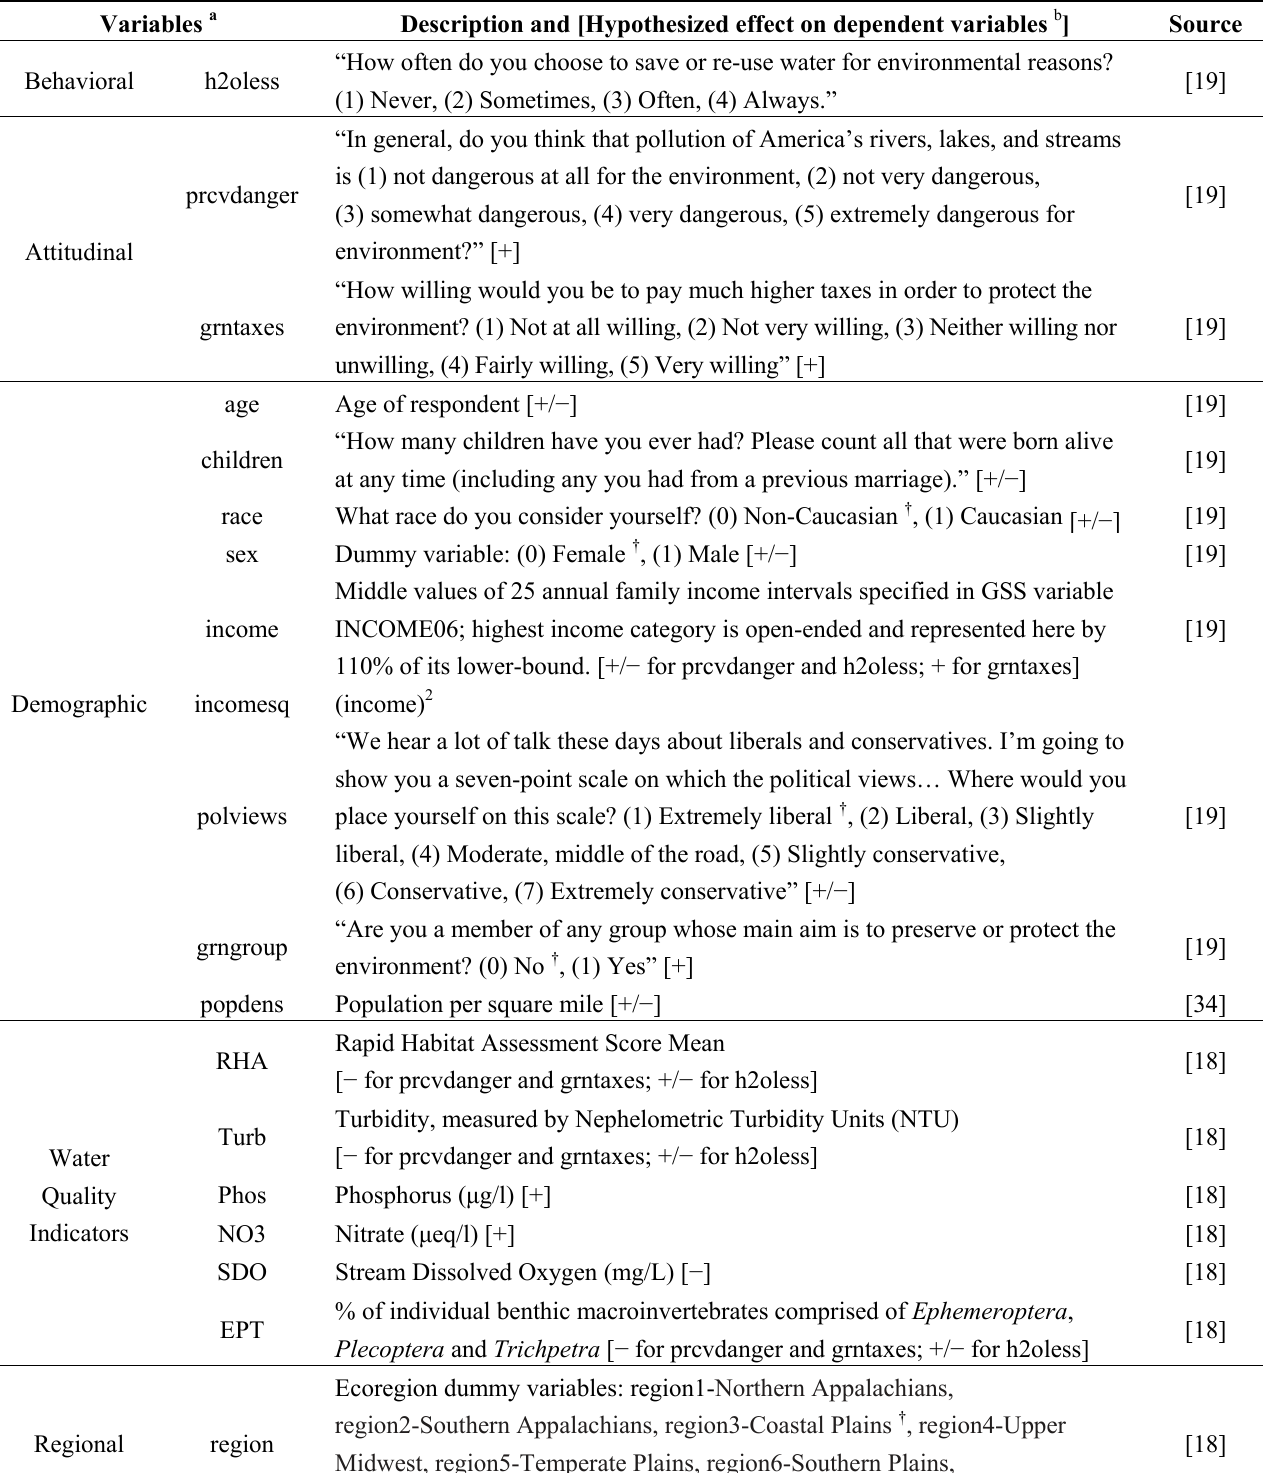
Table 1. Variables used in Case Study